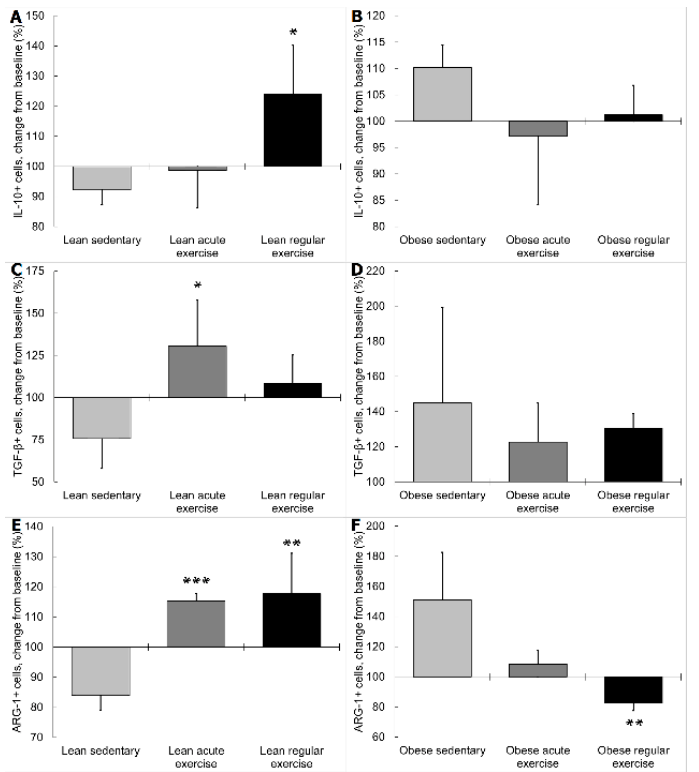
Figure 5. Effect of exercise on β 2 adrenergic regulation of monocytes expressing anti-inflammatory cytokines (IL-10, TGF- β ) and anti-inflammatory phenotype (ARG-1) in lean (sedentary n = 9; acute exercise n = 5; regular exercise n = 6) and obese mice (sedentary n = 8; acute exercise n = 5; regular exercise n = 6). Data are expressed as percentage change from baseline after β 2 adrenergic stimulation with terbutaline (giving “100” to the basal values in the absence of terbutaline): ( A , B ): IL-10 + cells in lean and obese mice, respectively. ( C , D ): TGF- β + cells in lean and obese mice, respectively. ( E , F ): ARG-1 + cells in lean and obese mice, respectively. Columns show the mean ± SEM of independent assays performed in duplicate in each animal. * p < 0.05, ** p < 0.01, *** p < 0.001 vs. the corresponding sedentary mice group.